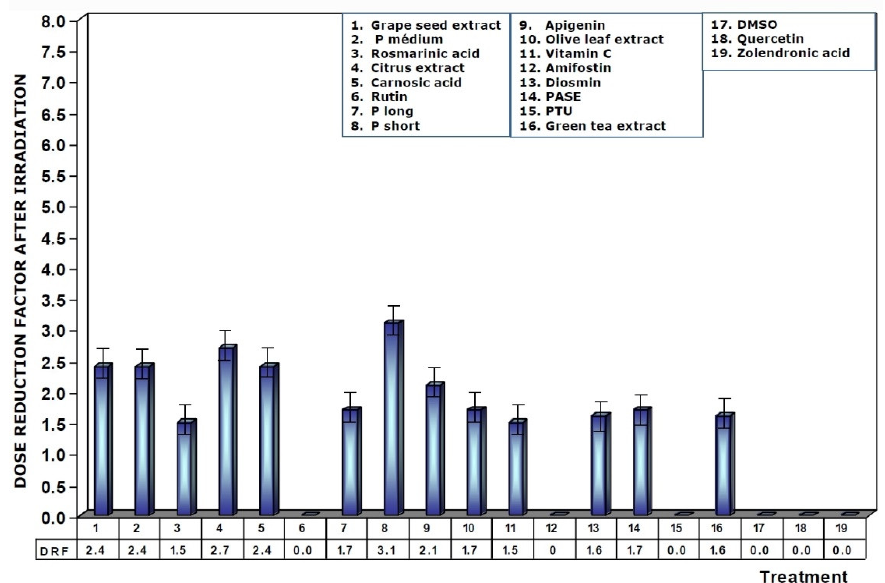
Figure 8. Dose reduction factors (DRFs) obtained when test substances were administered immedi- ately after exposure to ionizing radiation.